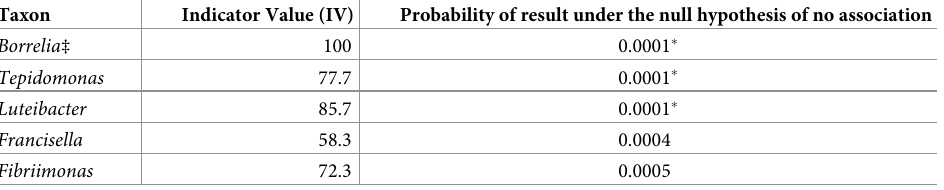
Table 2. Taxa over-represented in Borrelia -positive ticks as identified by indicator-species analysis with 15,999 simulations, arranged by probability of null association. Indicator values (IV) represent the combined relative abun- dance of a given taxon in a group ( Borrelia positive/negative) and the proportion of samples within that group that had that taxon; an IV of 100 indicates perfect association of a taxon with a group due to exclusive occurrence and high rela- tive abundance. Significance is determined by comparison of observed IVs with IVs generated from randomizations. No taxa were identified as being under-represented in Borrelia -positive ticks. Results were qualitatively similar whether or not Rickettsia sequences were included in the dataset. Asterisks indicate statistical significance at P = 0.0001 with the two taxa associated with P � 0.0005 listed as marginally-significant indicator taxa.